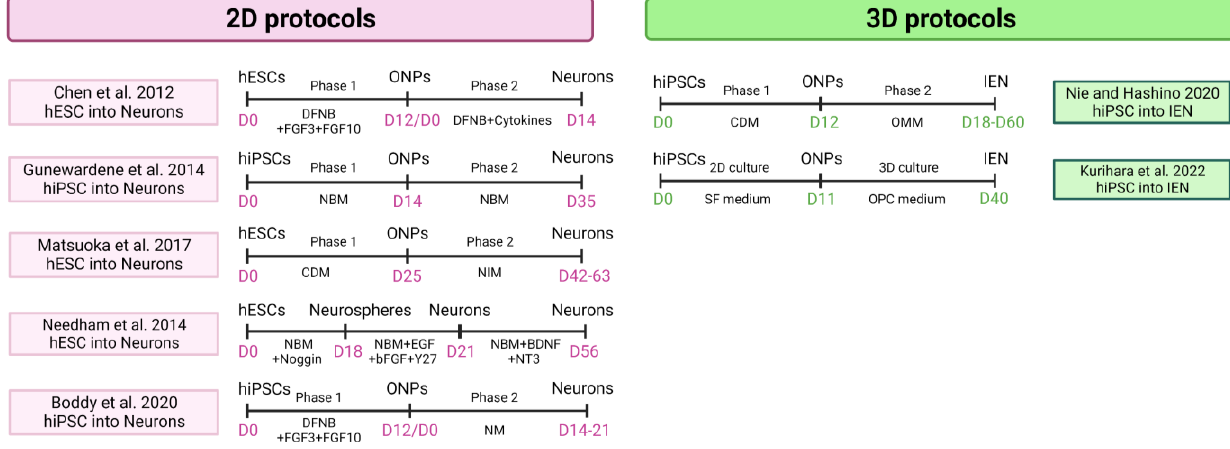
Figure 5. Cellular models of hPSC-derived 2D and 3D inner ear neurons protocols [100,101,103,109,113 – 115]. NBM: neurobasal medium. CDM: chemically defined medium. NIM: neural inducing medium. NM: neuralizing medium. (Created with BioRender.com, accessed on 22 March 2023).